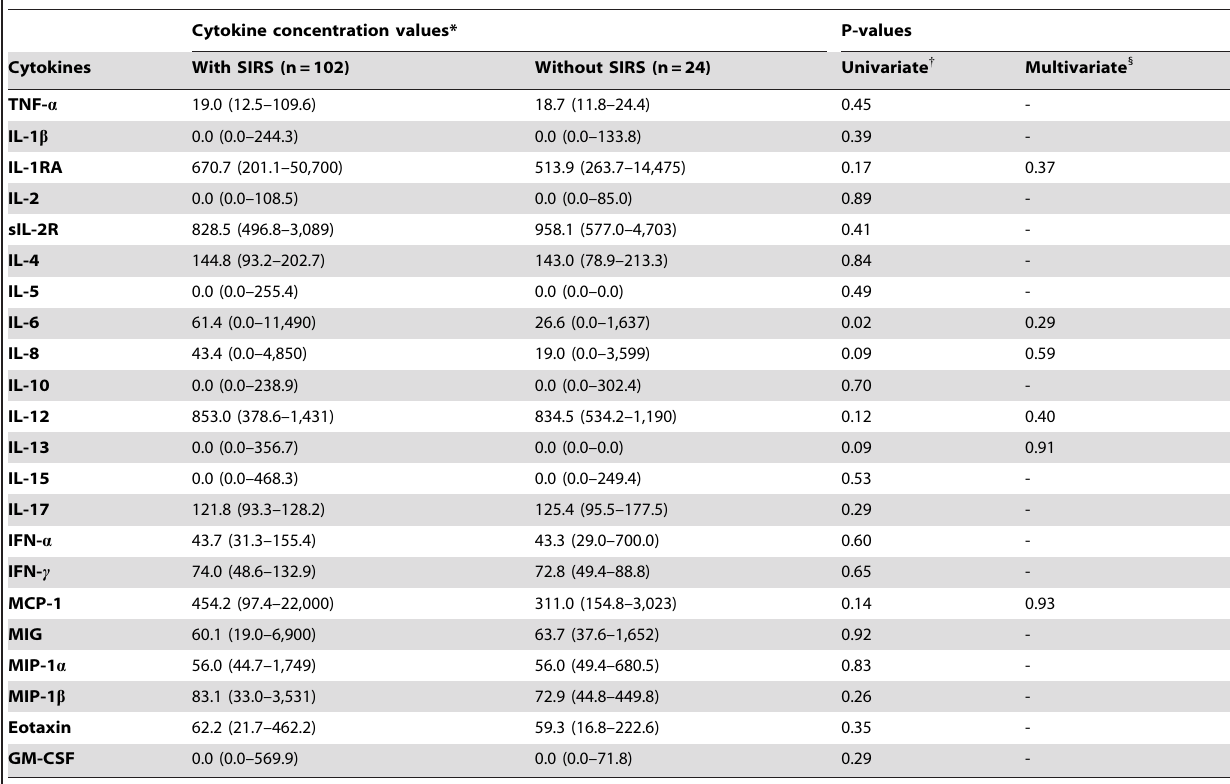
Table 2. Serum concentrations of cytokines in patients with and without